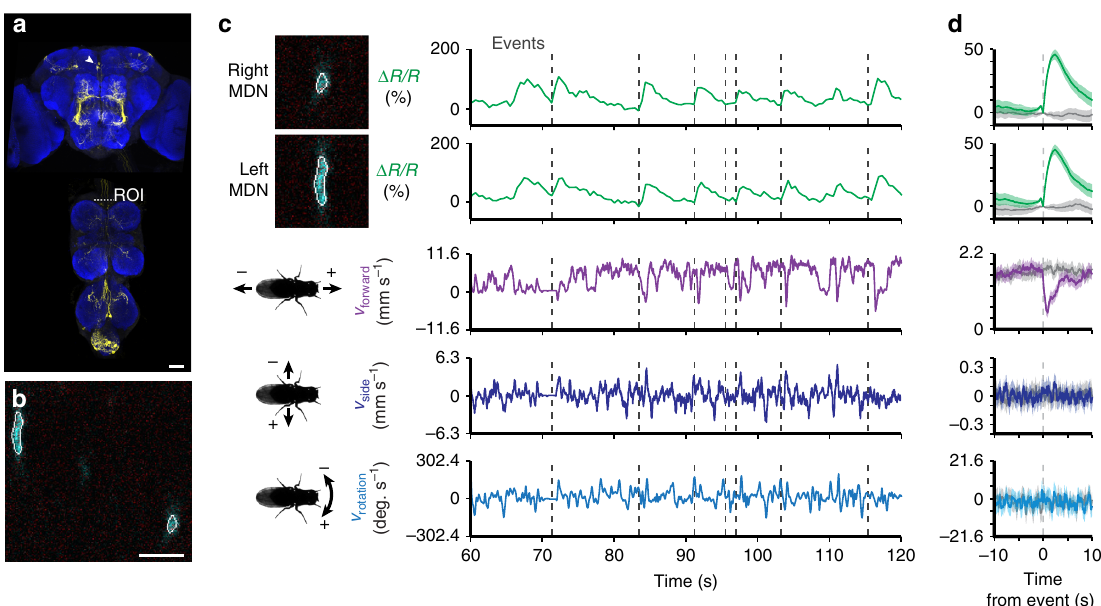
Fig. 4 Neural activity of MDNs in the thoracic cervical connective during behavior. a Confocal image of MDN-1-Gal4 driver line expression in the brain and VNC. Scale bar is 40 µ m. Neuronal GFP (yellow) and neuropil (nc82, blue) are labeled. A dashed white line highlights the thoracic x – z plane imaged. b Coronal section of the thoracic cervical connective in an animal expressing GCaMP6s (cyan) and tdTomato (red) in Moonwalker Descending Neurons ( MDN-1 > GCaMP6s; tdTomato ). Scale bar is 6 µ m. c Separated ROIs (top-left) and associated fl uorescence signals from right and left MDNs (top-right). Corresponding forward, sideways, and rotational velocities of the fl y (bottom-right). Events are indicated as dashed gray lines. d Summary of MDN activity and spherical treadmill rotations with respect to fl uorescence events (900 left neuron and 900 right neuron events) aligned to 0 s (dashed gray line). Control data in which events are time-shuf fl ed are overlaid in gray. Shown are the means (solid line) and bootstrapped 95% con fi dence intervals